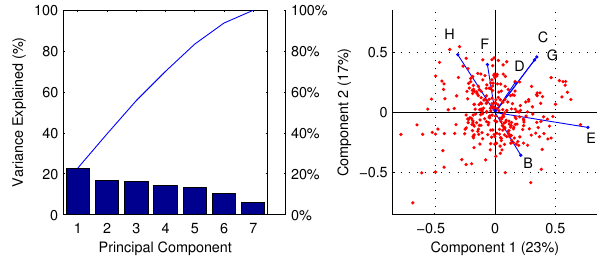
Figure 5. The first 5 principal components of the shallow ice core δ D records are compared with the Ni˜no 3.4 and SAM indexes. Strong El Ni˜no years (red lines) and strong La Ni˜na years (blue lines) are defined as 5 consecutive months greater than or less than 1.5 degree Celsius sea surface temperature anomalies for the Ni˜no 3.4 region, respectively.